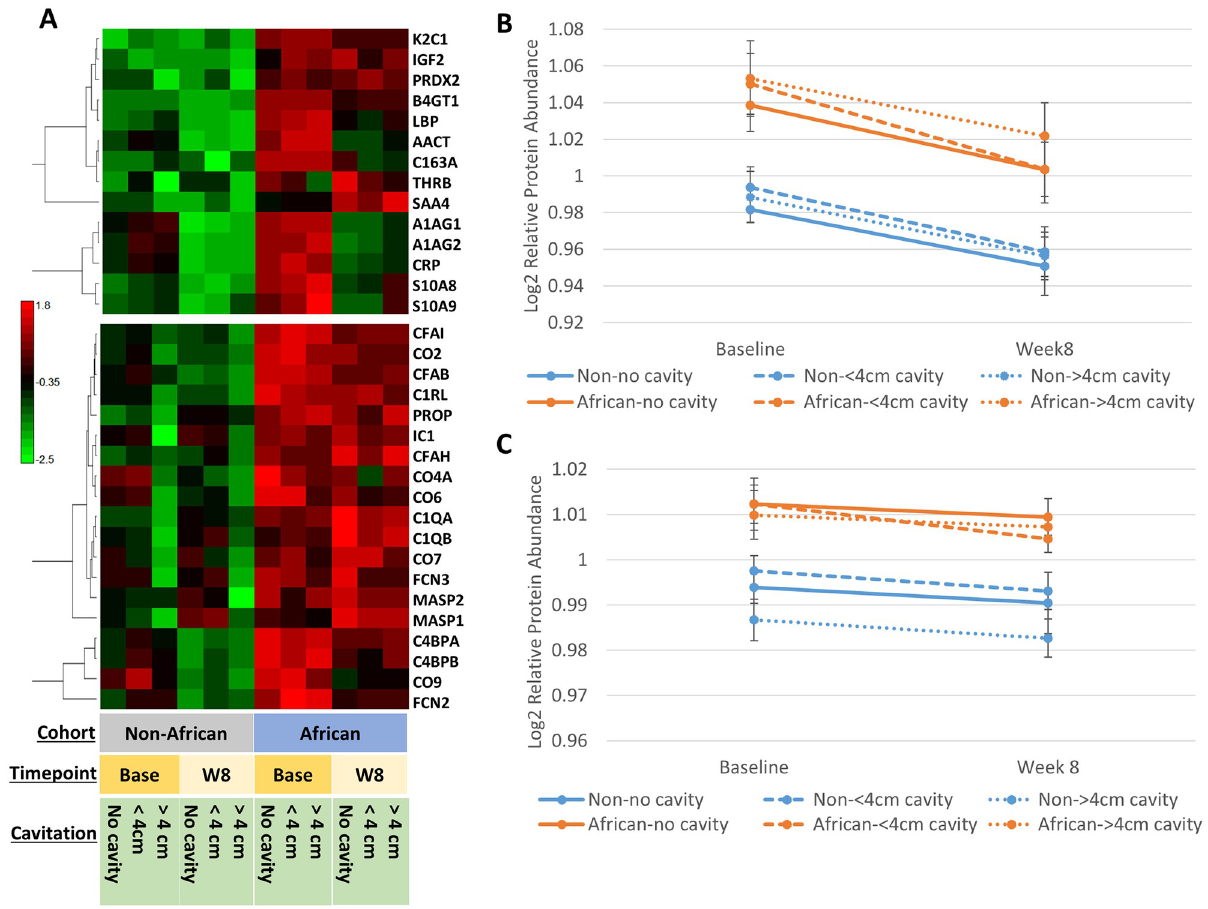
Fig 5. Comparison of inflammatory and complement activation plasma signature. A) Heatmap, Pearson correlation, of proteins found in the acute inflammatory response and complement activation pathways from Fig 2C, with redundancy removed. Results are stratified across cohort, timepoint, and disease severity as determined by cavitary size by baseline chest radiograph. B) Graph of the composite (14 proteins from panel A ) acute inflammatory protein signature across timepoint and disease severity C) Graph of the composite (19 proteins from panel A ) complement activation protein signature across timepoint and disease severity. Values in panel B) and C) represent median protein abundances from a scaled normalization within each protein across time point and cohort. Error bars represent the standard deviation across the median protein values.